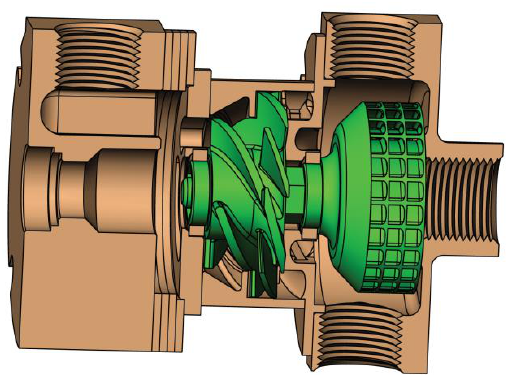
Figure 14. 3D model of the hybrid turbopump (variant). Source: authors’ development.